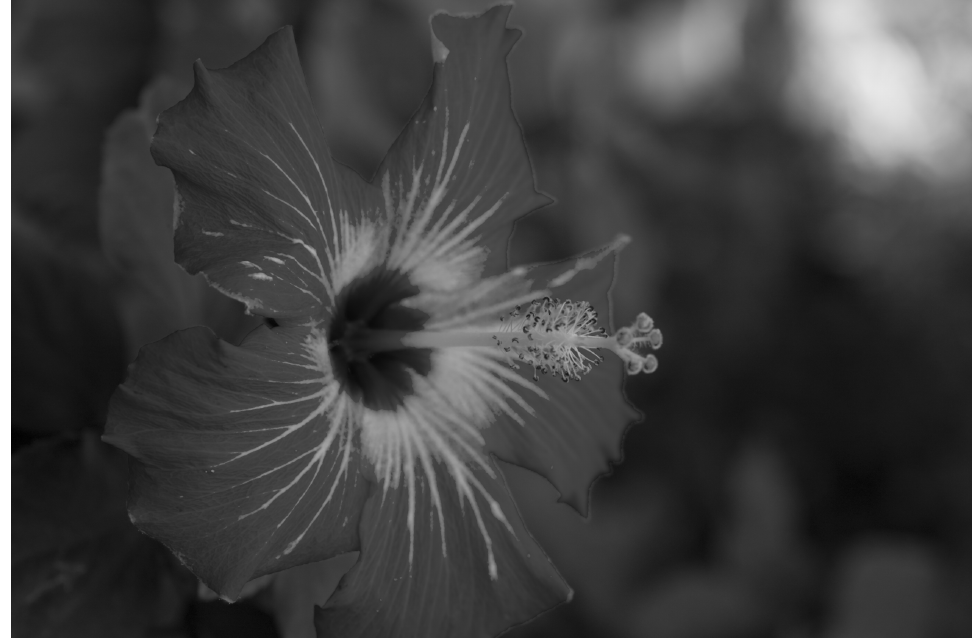
Figure A1. Picture of a flower (8-bit, 2268 × 1512) from the Rawzor dataset. Lossless compression bpp using LOCO-ANS6: 1.983.